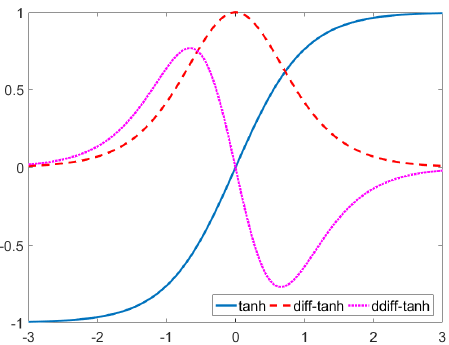
Figure 3. The curves for tanh function and its derivatives,